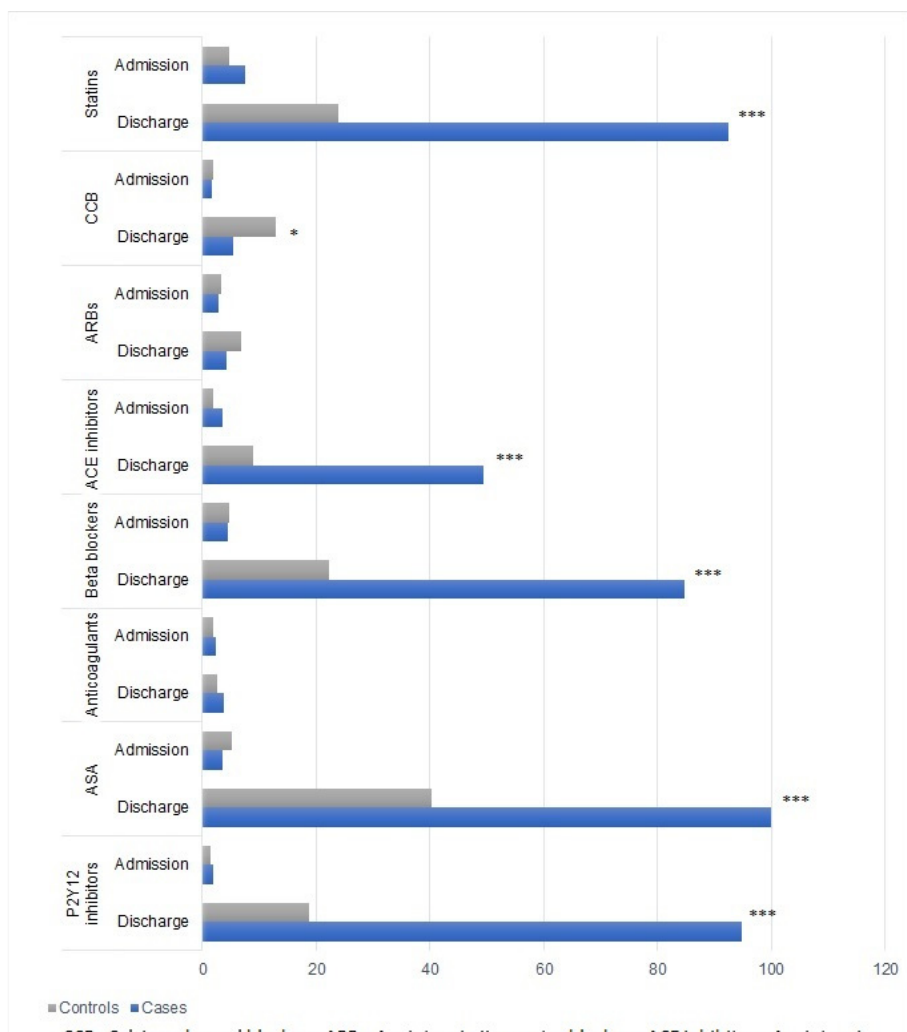
Figure 3. Pharmacological treatment at hospital admission and at discharge.